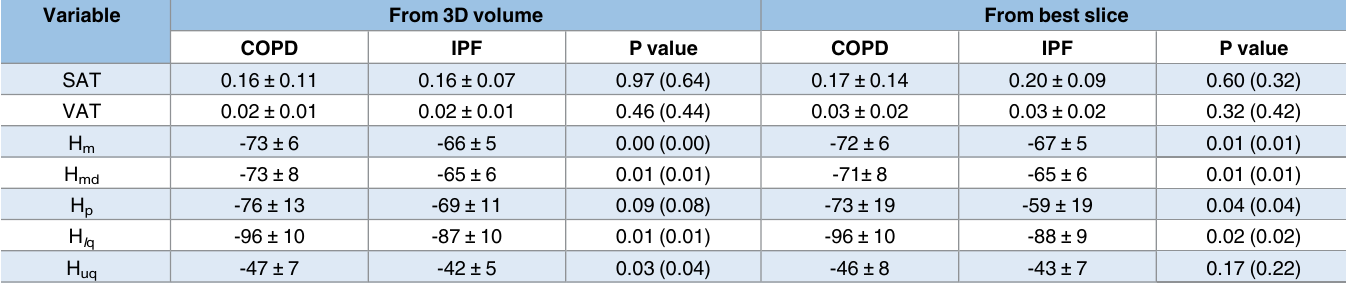
Table 6. Fat volume, area, and attenuation histogram properties on chest CT for COPD (n = 16) and IPF (n = 16) groups. Variable From 3D volume From best